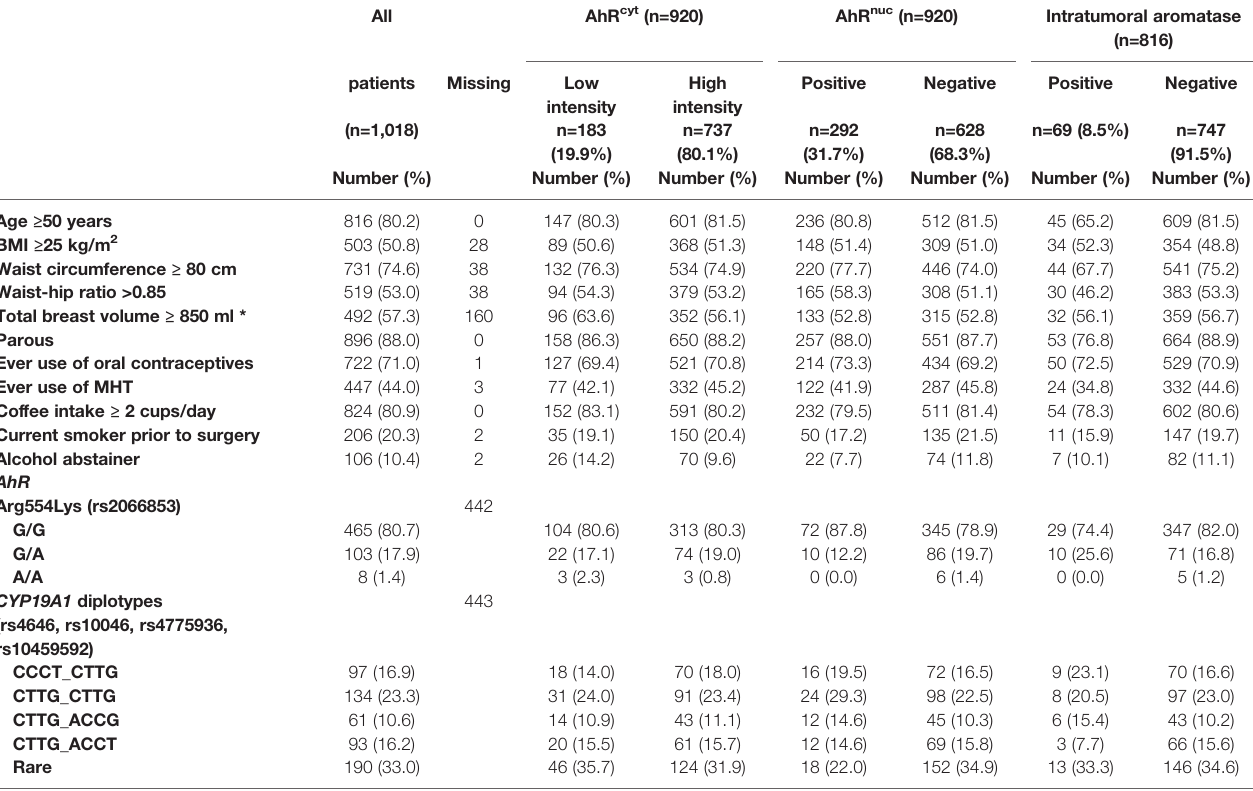
TABLE 1 | Patient characteristics at inclusion in relation to AhR cyt , AhR nuc, and aromatase levels.